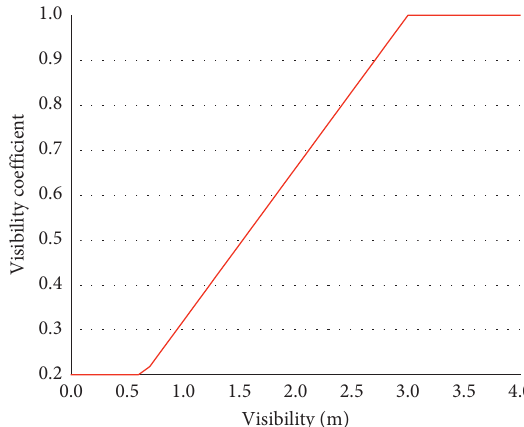
Figure 3: Impact of visibility on evacuation